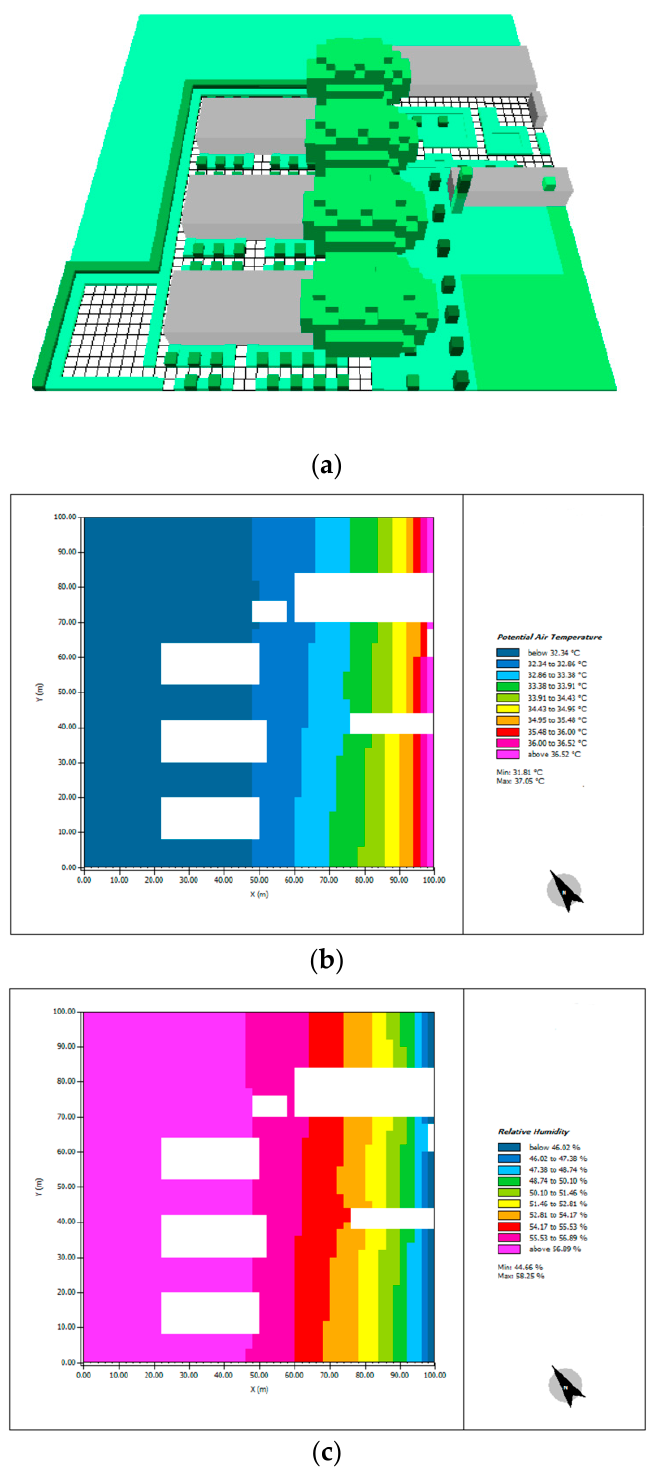
Figure 11. ( a ) ENVI-met model of the road area with 75% coverage; ( b ) ENVI-met simulated Ta